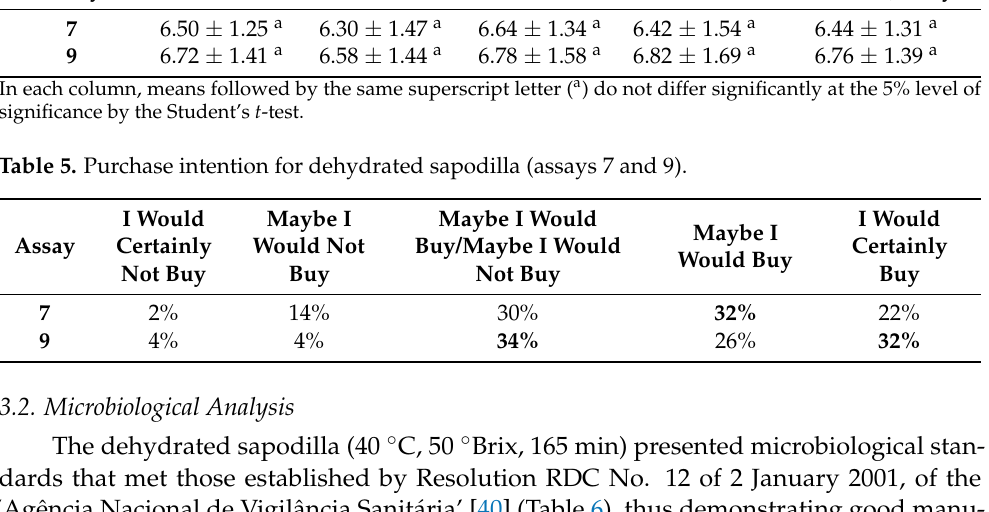
Table 4. Mean acceptance scores for dehydrated sapodilla (assays 7 and 9). Assay Aroma Color Taste Texture Global Quality